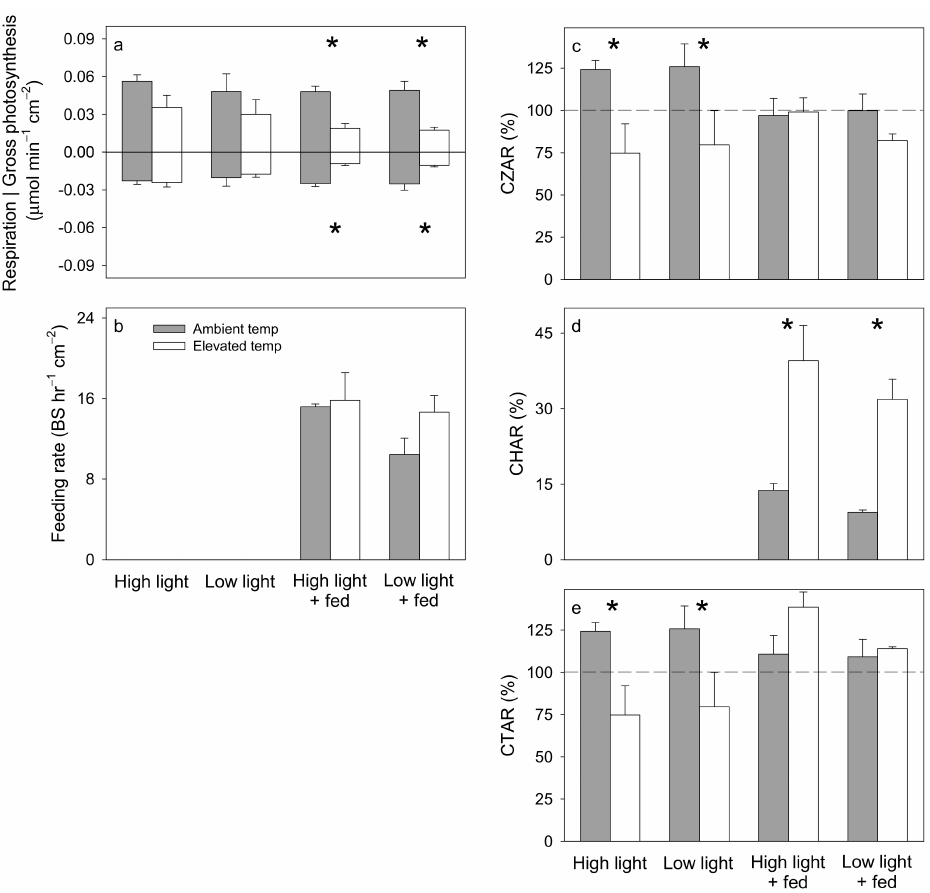
Figure 8. Turbinaria reniformis average ( ± 1 SE) ( a ) photosynthesis and respiration, ( b ) feeding rate, ( c ) Contribution of Zooxanthellae (Symbiodiniaceae) to Animal Respiration (CZAR), ( d ) Contribution of Heterotrophy to Animal Respiration (CHAR) from feeding on Artemia nauplii, and ( e ) Contribution of Total acquired fixed carbon relative to Animal Respiration (CTAR), under ambient temperature (25 ◦ C, solid bars) and elevated temperature (30 ◦ C, open bars) within high light (300 µ mol pho- tons m − 2 s − 1 , unfed), low light (150 µ mol photons m − 2 s − 1 , unfed), high light + fed (300 µ mol photons m − 2 s − 1 , fed), and low light + fed (150 µ mol photons m − 2 s − 1 , fed) treatments. Asterisks indicate significant differences between the ambient and elevated temperature treatments within each light and feeding treatment combination. N = 3 for all averages. Significant effects from corresponding ANOVAs in Table